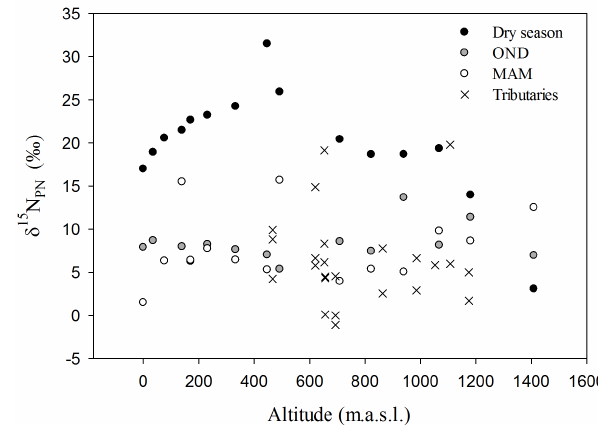
Fig. 6. Altitudinal gradient during dry season (August–September 2011), short rain season (October–December, OND, November 2011) and long rain season (March–May, MAM, April 2012) and all tributaries (x, all seasons) of in-stream δ 15 N PN